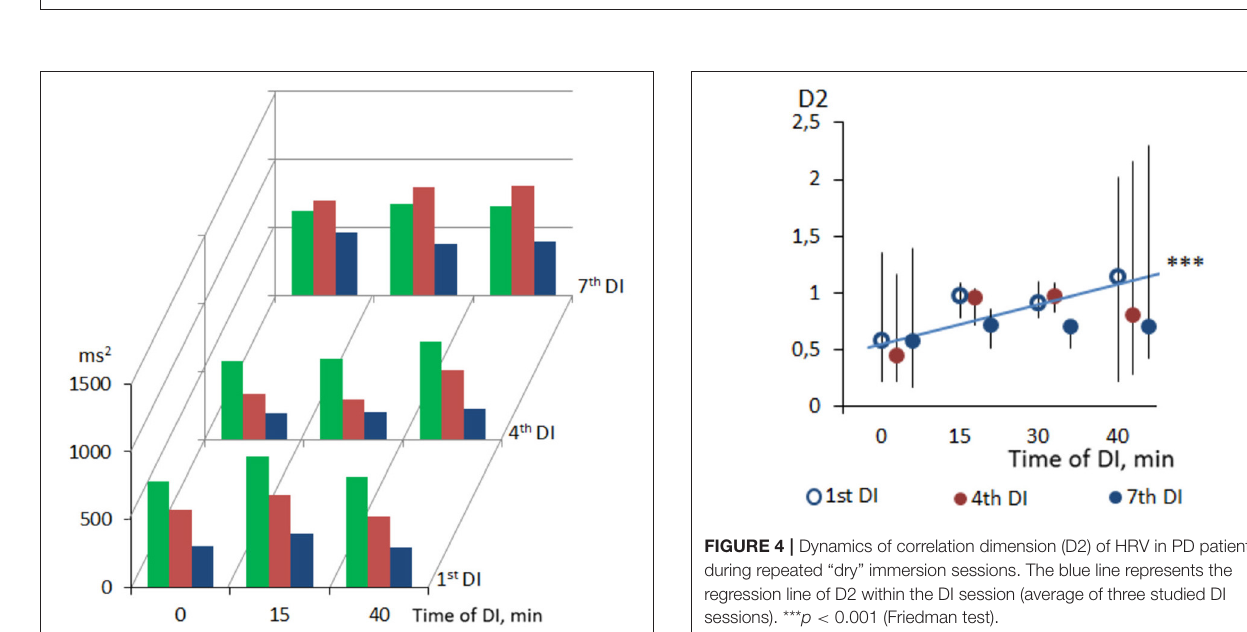
after the session of warm water immersion (Sugawara and Tomoto, 2020). In the study of Brunt et al. (2016), the program of five 1-h warm water immersion at 40.5 ◦ C within 8 weeks (“passive heat therapy”) significantly increased flow-mediated arterial dilatation, reduced arterial stiffness mean arterial and diastolic BP, and carotid intima-media thickness in young healthy subjects. In the present study, the water temperature at DI was 32 ◦ C, which can generally be considered as